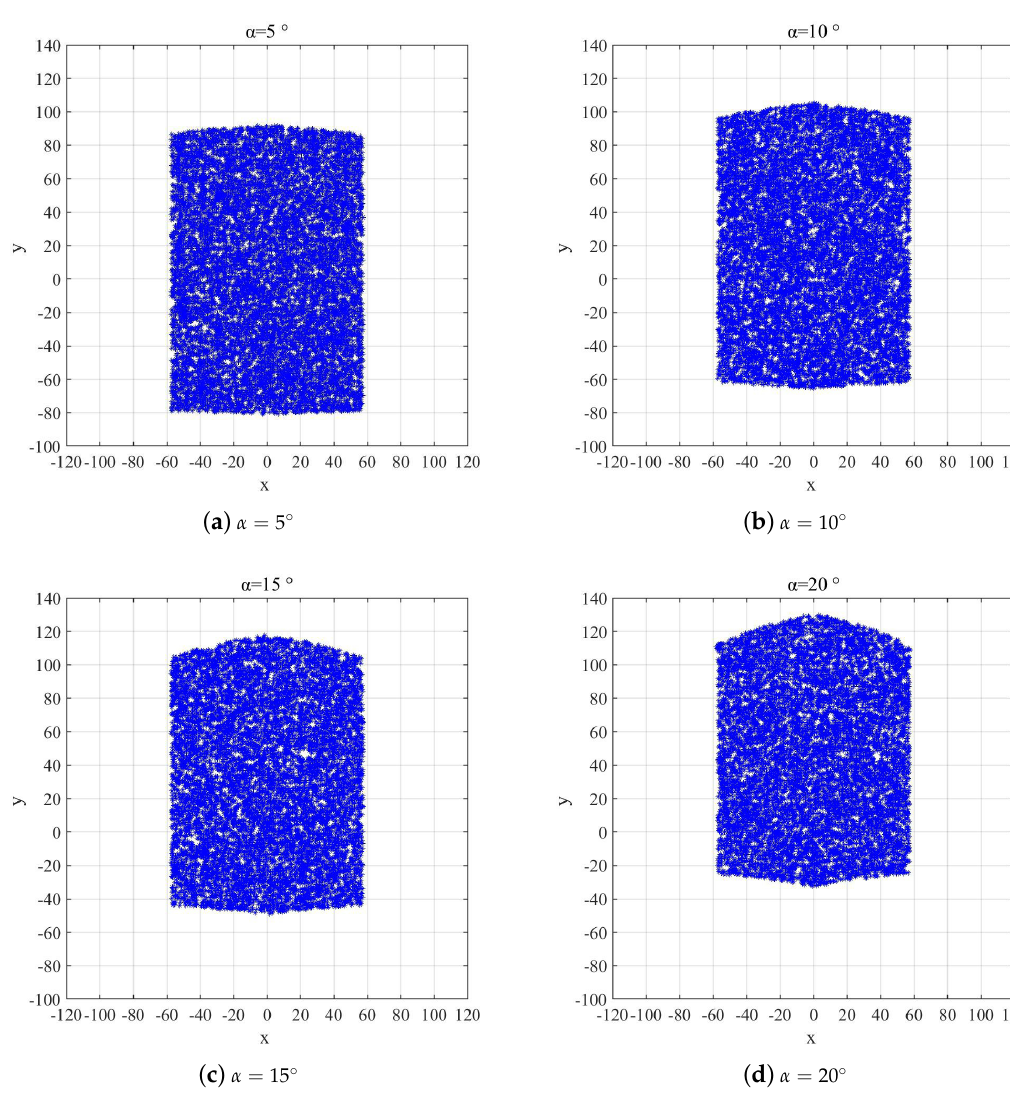
Figure 16. Fixed posture workspace of α